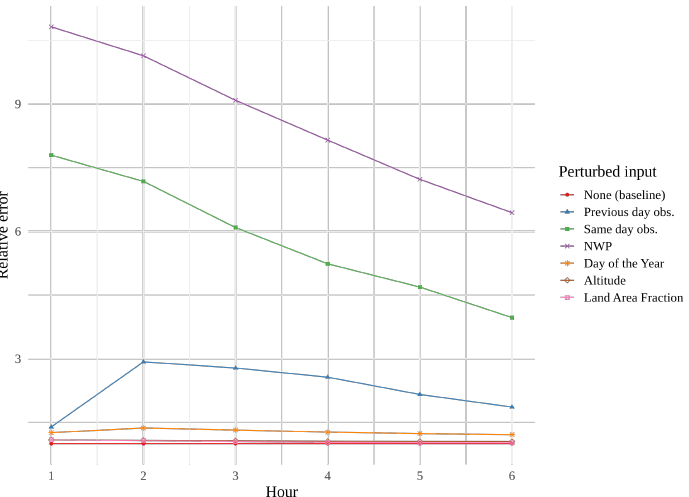
Figure 14. Permutation feature importance of the best CNN, i.e., the error resulting from the permu- tation of one parameter, leaving the remaining parameters